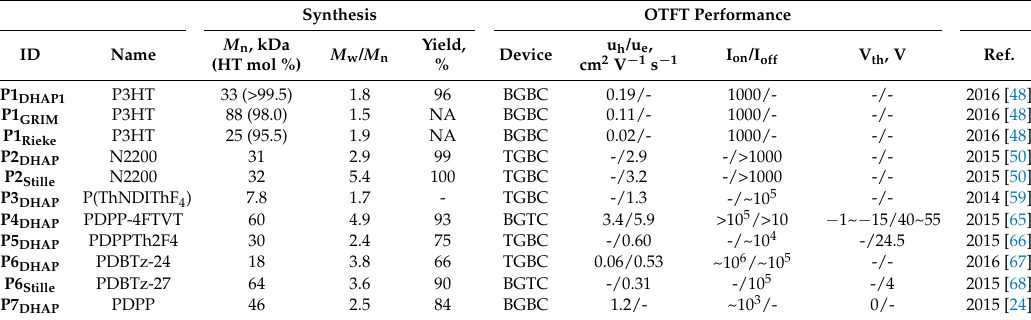
Table 1. Comparison of Polymeric Materials Used in Thin Film Transistors. Synthesis OTFT